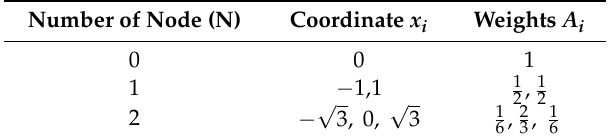
Table 2. Coordinates and weights for the standard normal distribution ( x =